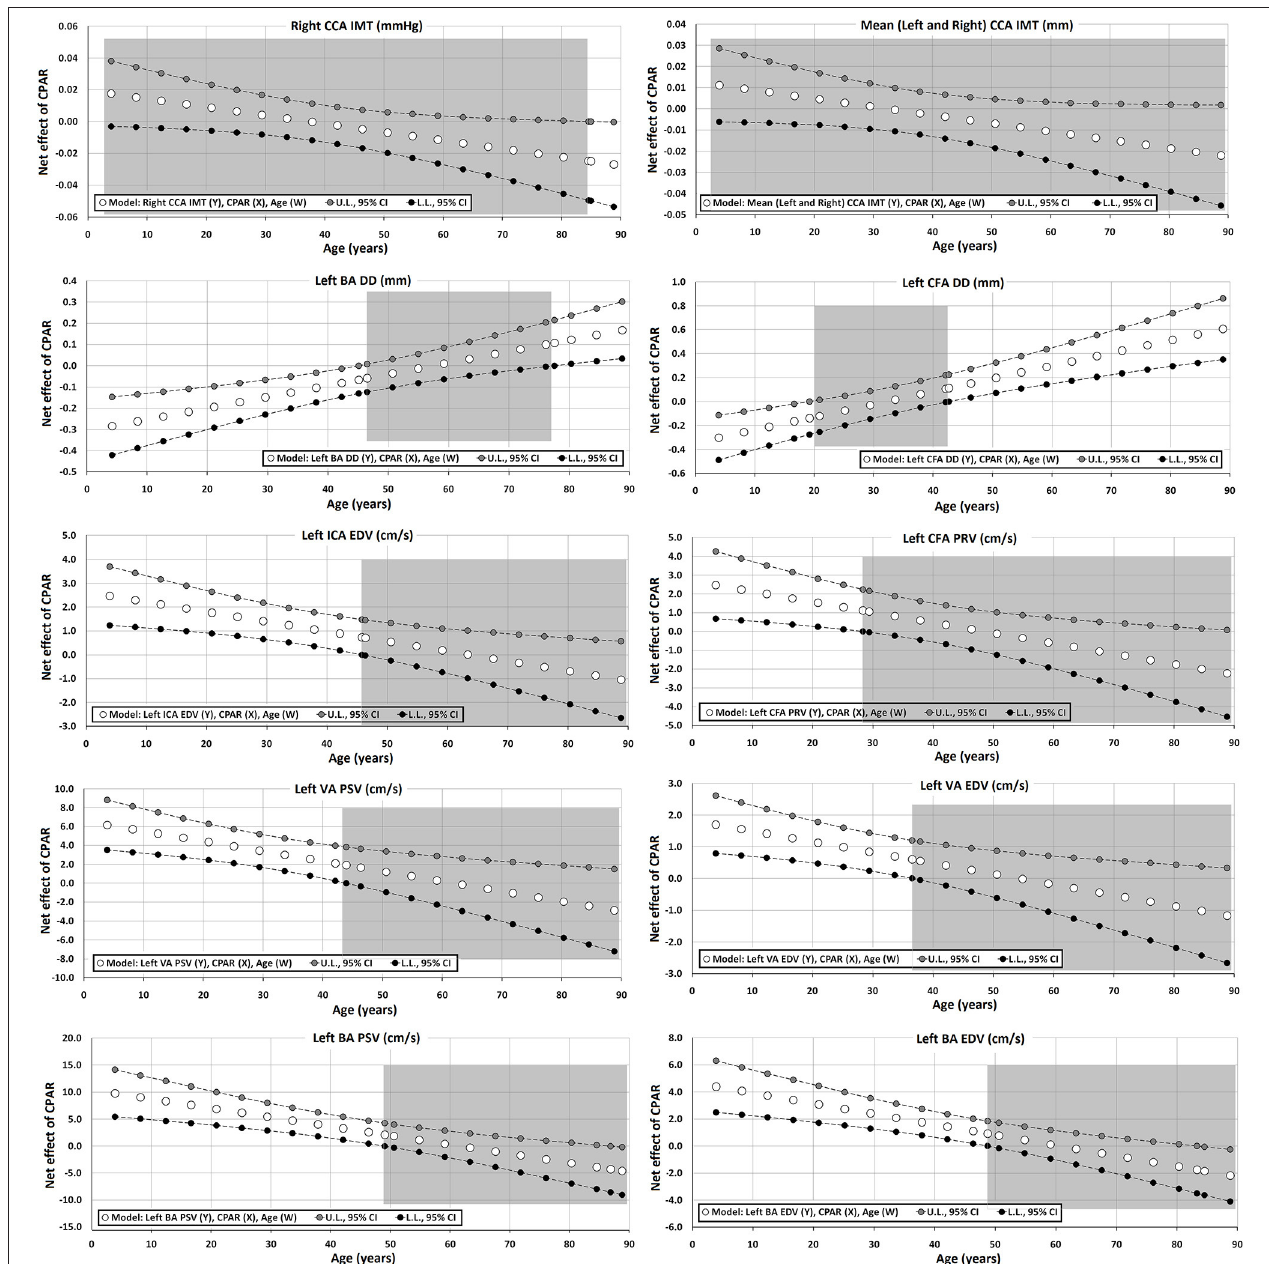
FIGURE 6 | Effect of CPAR condition on arterial structural (intima-media thickness and arterial diameters) and blood flow velocity levels: effects at different ages throughout life. The gray area shows regions that do not reach statistical significance. Complete quantitative information related to interactions and/or Johnson-Neyman regions is detailed in Supplementary Tables 2 – 95 . In each panel, the “net or absolute conditional effect” (and its 95% confidence interval) of reaching CPARs = 1, quantified in units of the cardiovascular variable, was plotted as a function of age. If the confidence interval crosses the value “0,” the effect of CPARs on the cardiovascular variable becomes statistically non-significant ( p ≥